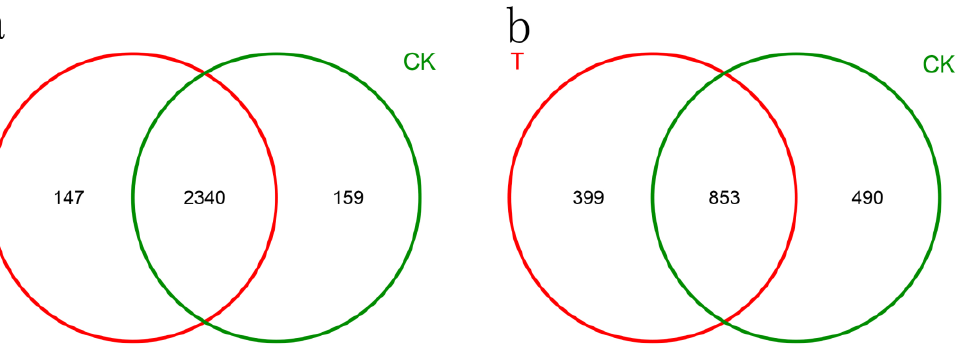
Figure 5. Venn diagram exhibiting unique, as well as shared ( a ) bacterial OTUs ( b ) fungal OTUs for the two treatments. The T6-1 group included poplar trees, which were exposed to bacterial zymotic fluid with T6-1. The CK group consisted of poplar trees, which were exposed to an equivalent volume of sterile zymotic fluid. We analyzed three replicates for every treatment.